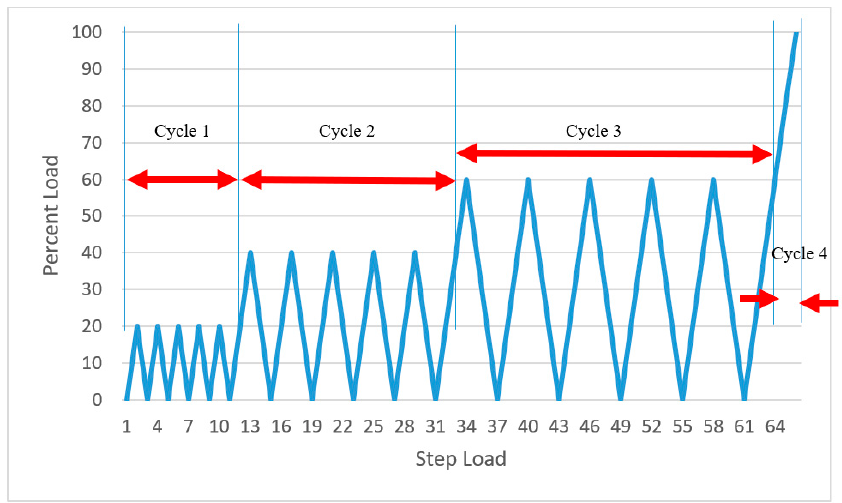
Figure 4. Step load for the four-point bending with loading/unloading branches.